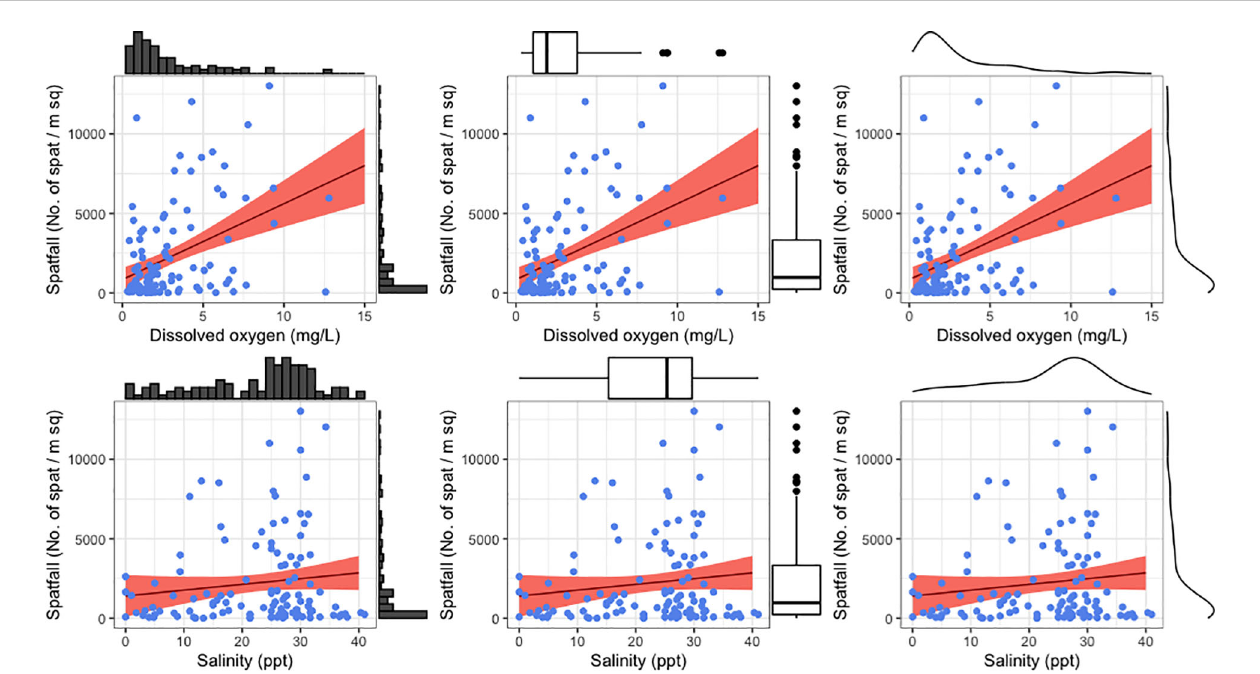
FIGURE 8 Marginal plots with histogram, boxplot and density plot visualisations for the relationship between spatfall and the most signi fi cant hydrographic parameters, salinity and dissolved oxygen, in the ecosystems studied. A moderately positive statistically signi fi cant relationship exists between the two predictors and spatfall [Dissolved oxygen (r = 0.47, R 2 = 0.44); Salinity (r = 0.42, R 2 = 0.18); P < 0.001]. The dark red line is the model-predicted data, the salmon-red ribbon is the 95% Con fi dence Interval region, and the corn fl ower-blue points are observed data